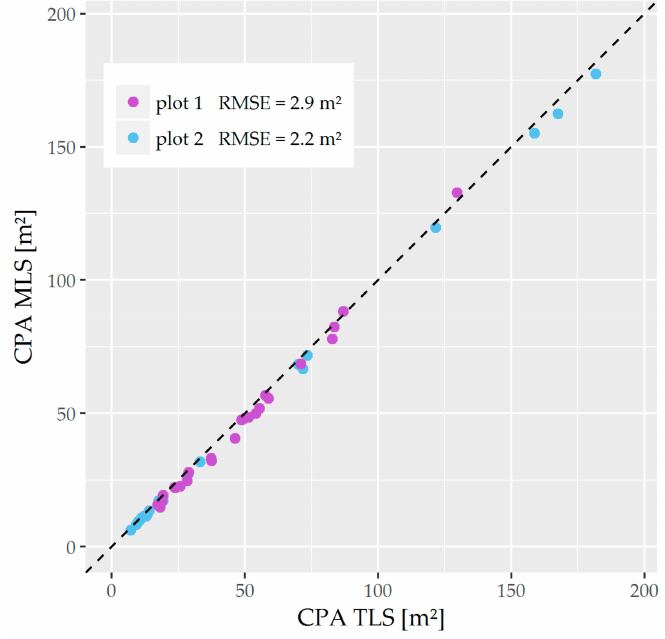
Figure 10. Crown projection area captured from the segmented